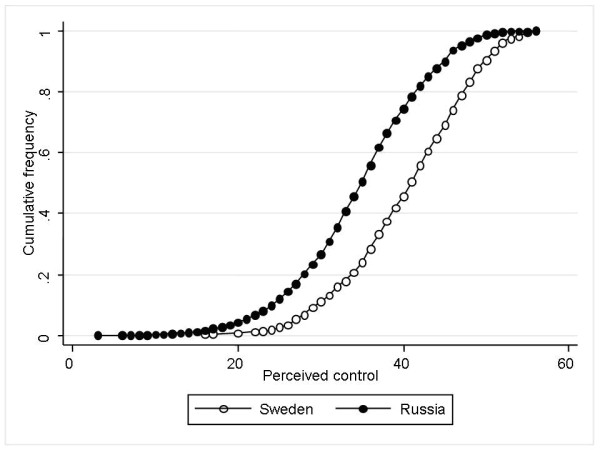
Cumulative frequency of perceived control scores in Sweden and Russia.